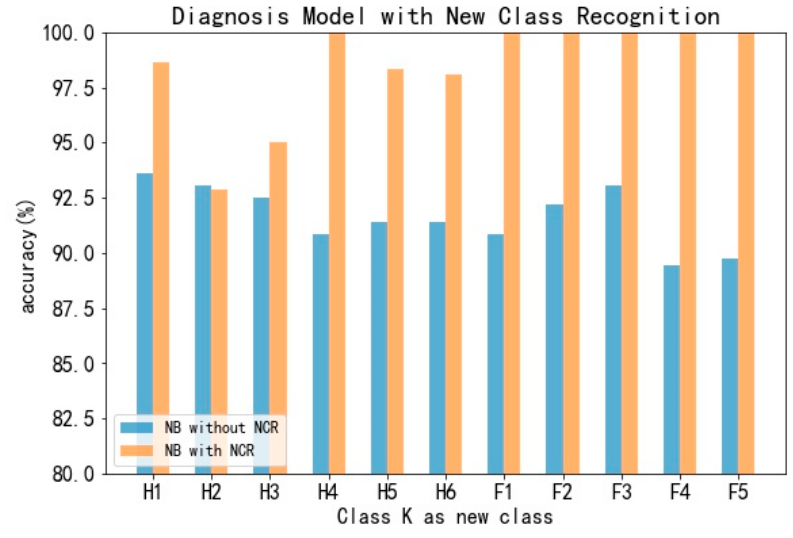
Figure 9. Result of scalable fault recognition.